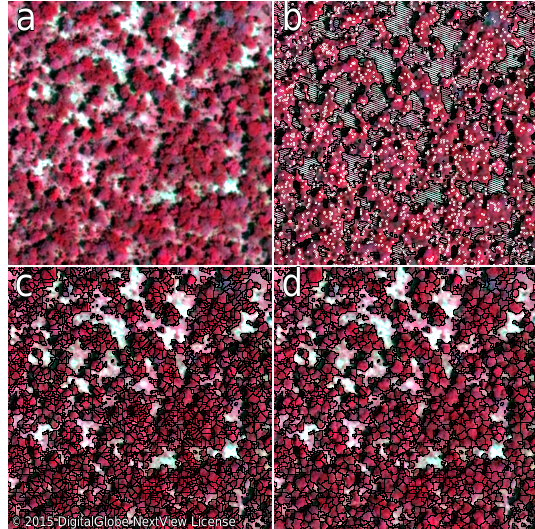
Figure 3. Crown delineation steps for a woodland site in Zambia. (a) Pan-sharpened false-color image, (b) local NDVI maxima as white points and the non-woody areas shown as striped polygons, (c) crown segments before merging, and (d) the final crown poly- gons following crown